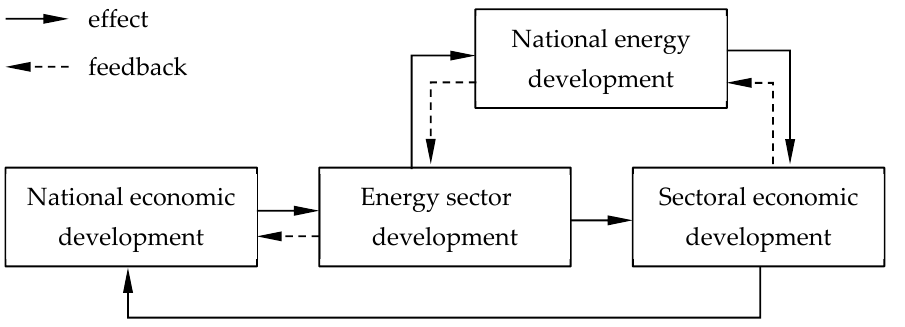
Figure 2. Principal model of the relationship between national economic development and energy sector development (source: compiled by the authors).